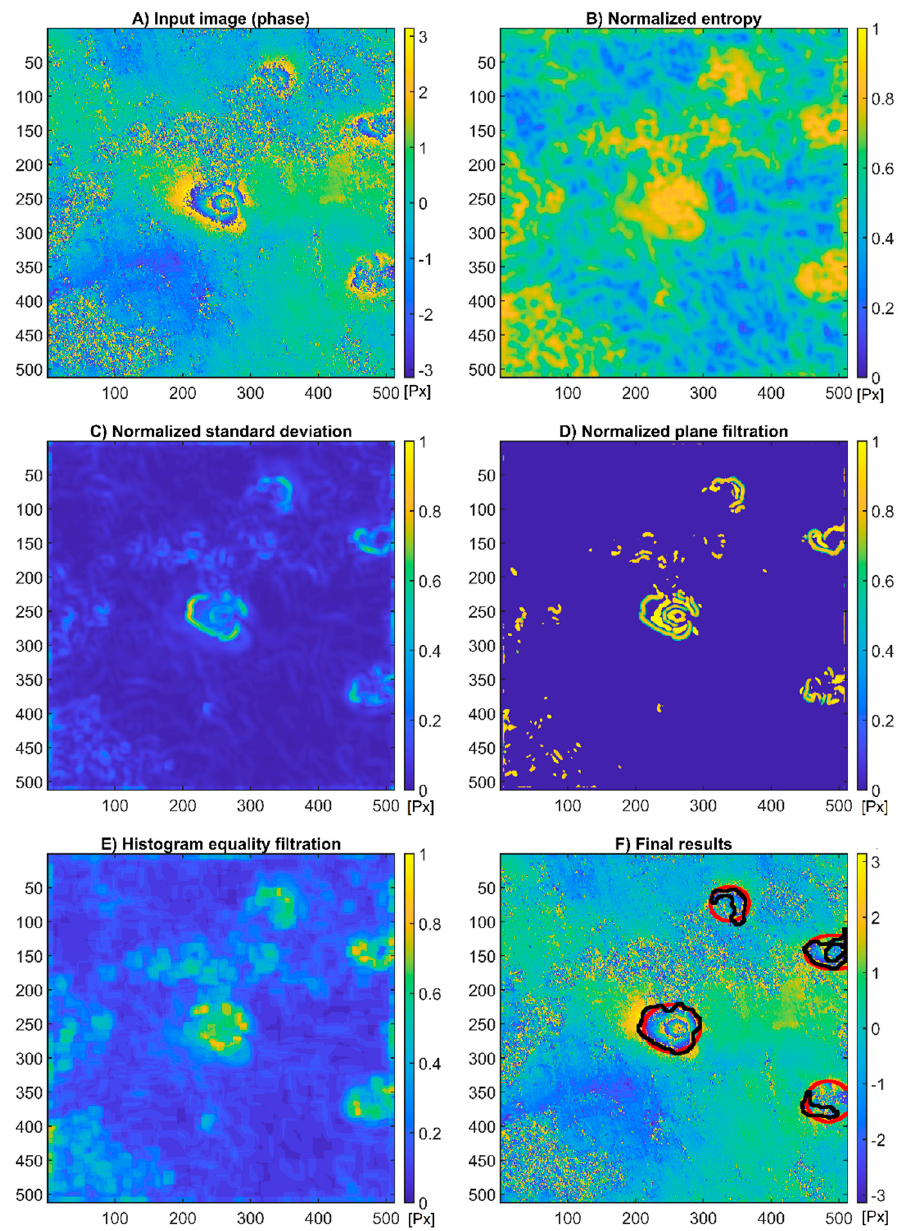
Figure 6. An example of subsidence detection algorithm efficiency with a particular focus on the results of particular algorithm operations. The interferogram computed from the radar images recorded on 4 April 2017 and 16 April 2017 for the area of the Upper Silesian Coal Basin, Poland (Sentinel-1A, descending).